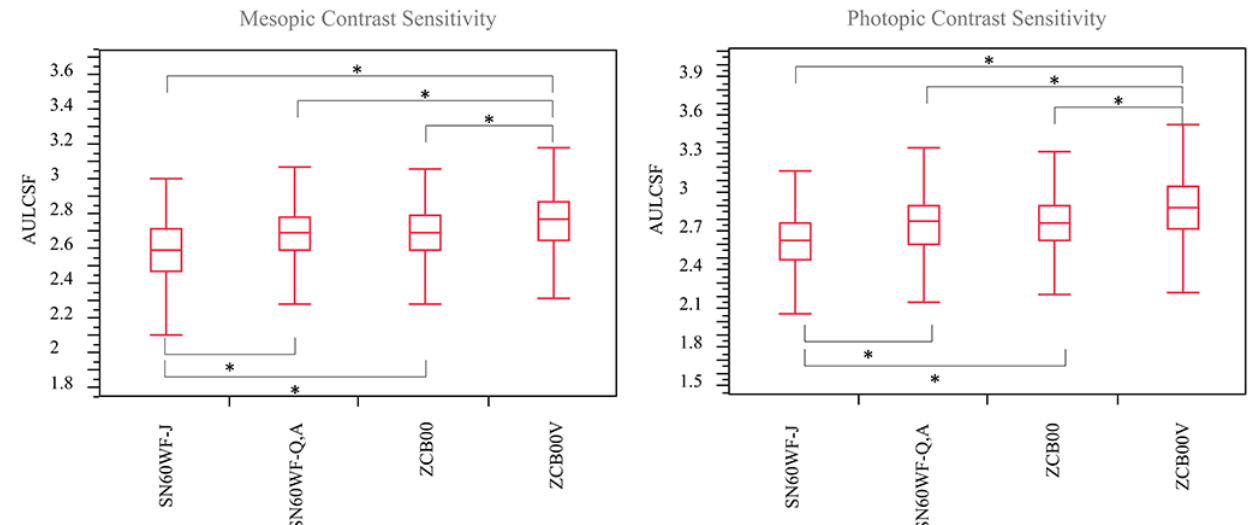
Figure 5. With regard to contrast sensitivity, the mesopic AULCSF were significantly poorer in the SN60WF-J group than in the other three groups. The ZCB00V group showed significantly higher values than the other three groups. No significant differences were observed between the SN60WF-Q,A and ZCB00 groups. * Tukey–Kramer test, p < 0.05.